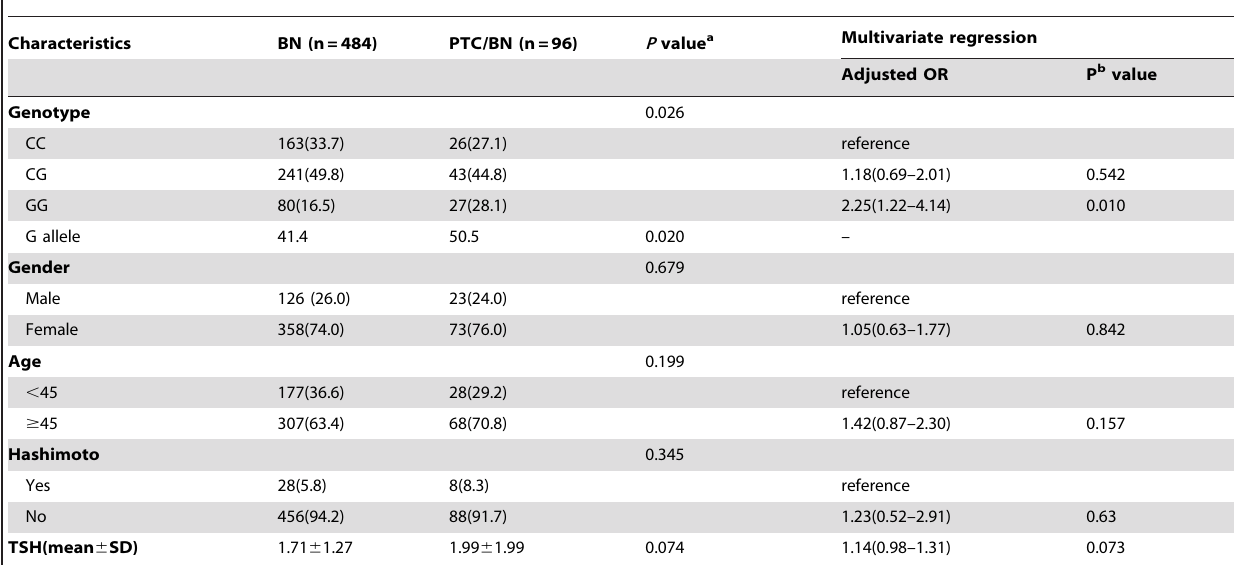
Table 5. The clinical and genectic characteristics of benign tumor (BN) and PTC with para-cancer benign tumor (PTC/BN).